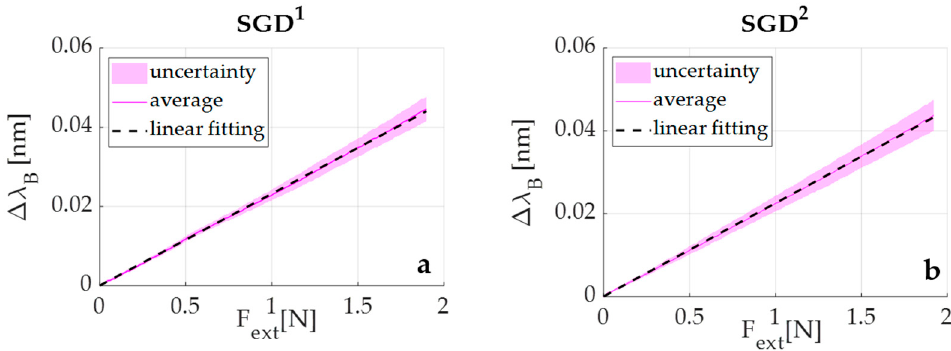
Figure 7. The Δλ B vs. F ext of SGD 1 ( a ) and SGD 2 ( b ): in continuous magenta lines the average Δλ B vs. F ext responses, in shaded magenta areas the related uncertainties, and in dotted black lines the best linear fitting.